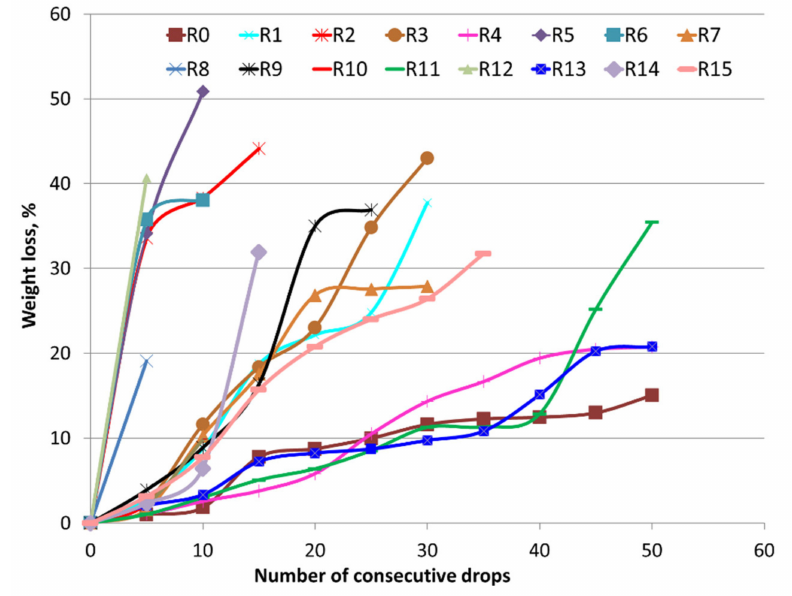
Figure 3. Weight loss during the drop test of different briquettes.